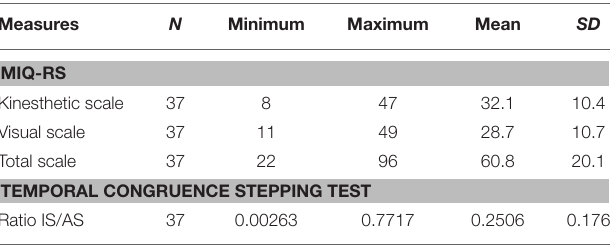
TABLE 2 | Performance of stroke patients on behavioral motor imagery ability